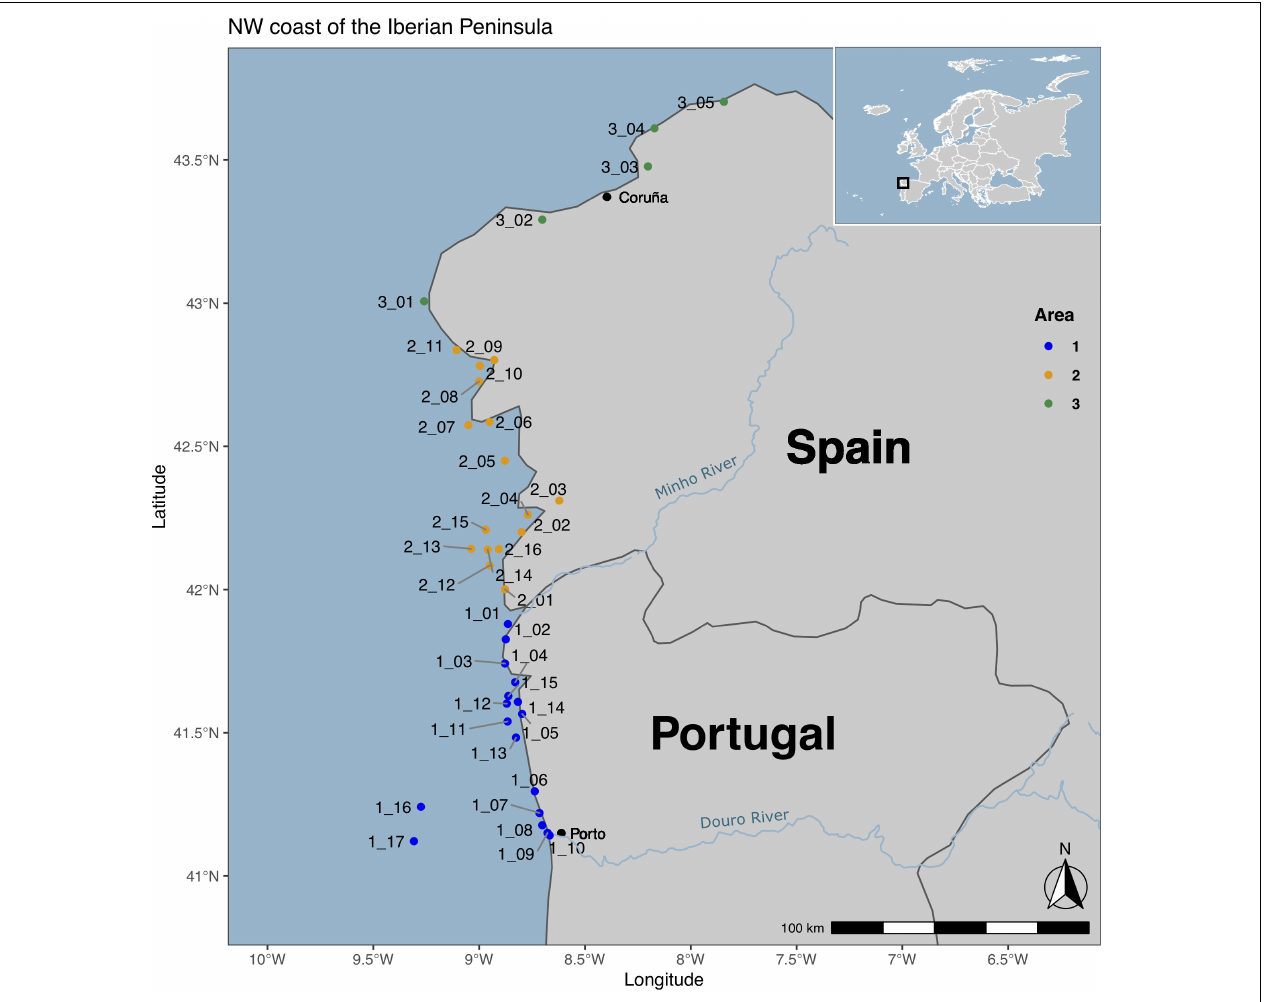
FIGURE 1 | Location of the 47 sampling sites along the NW coast of the Iberian Peninsula. This map was created using R v.3.6.1 (Team, 2019), R packages ggpplot2 (Wickham, 2016), sf (Pebesma, 2018), ggspatial (Dunnington, 2020), and rnaturalearth (South, 2017). The rivers were downloaded from http://tapiquen-sig.jimdofree.com (Carlos Efraín Porto Tapiquén. Geografía, SIG y Cartografía Digital. Valencia, Spain, 2020). The map was edited using Inkscape v.